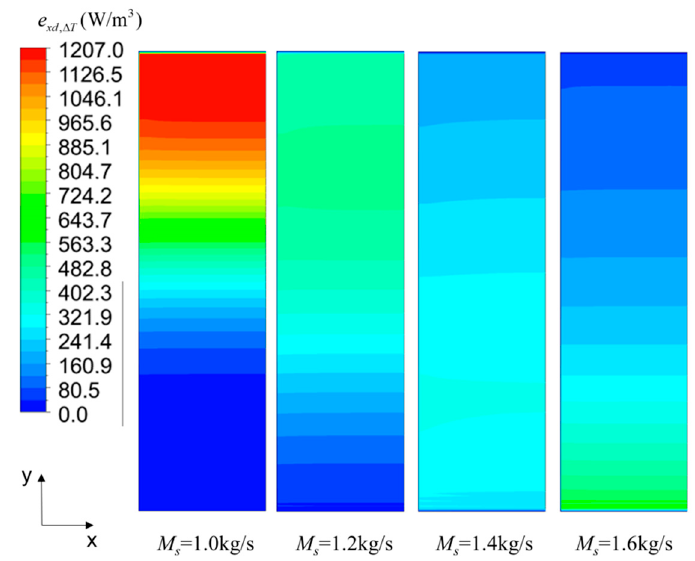
Figure 13. The distributions of the local heat transfer exergy destruction rate for different sinter mass flow rates.